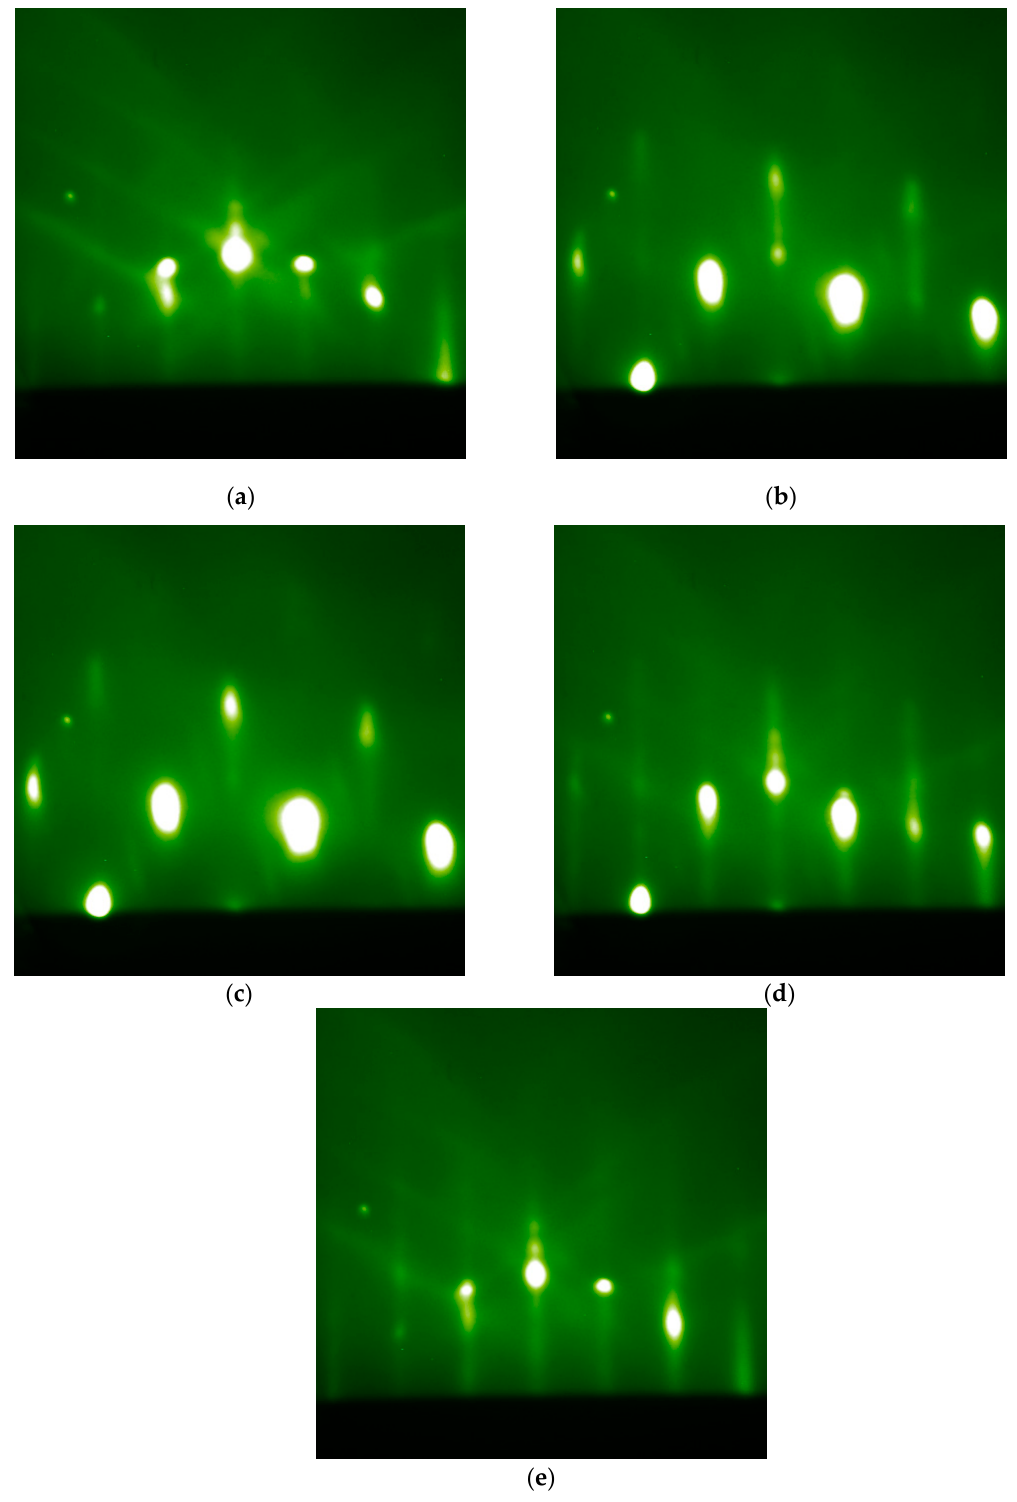
Figure 1. Reflection of high-energy electron diffraction (RHEED) pattern for InP(311)B substrate ( a ) after growth of the InP buffer layer, ( b ) after irradiation of As for 180 s at 470 °C, ( c ) for 240 s at 470 °C, ( d ) for 240 s at 450 °C, and ( e ) for 240 s at 430 °C.